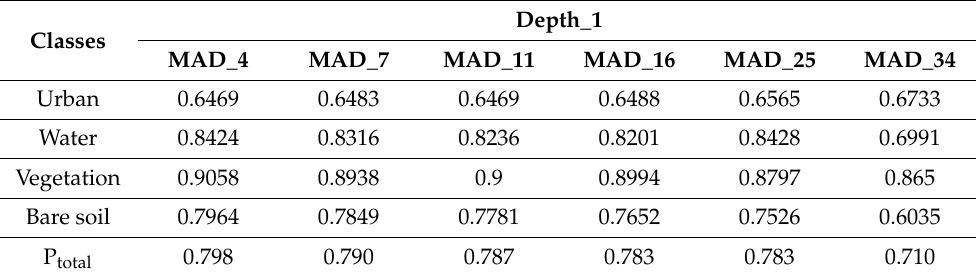
Table 13. Probabilities for classes and total probabilities of correct classification for depth 1 and different MAD.